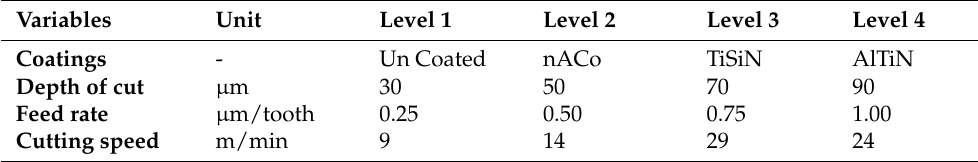
Table 2. Design of experiment.